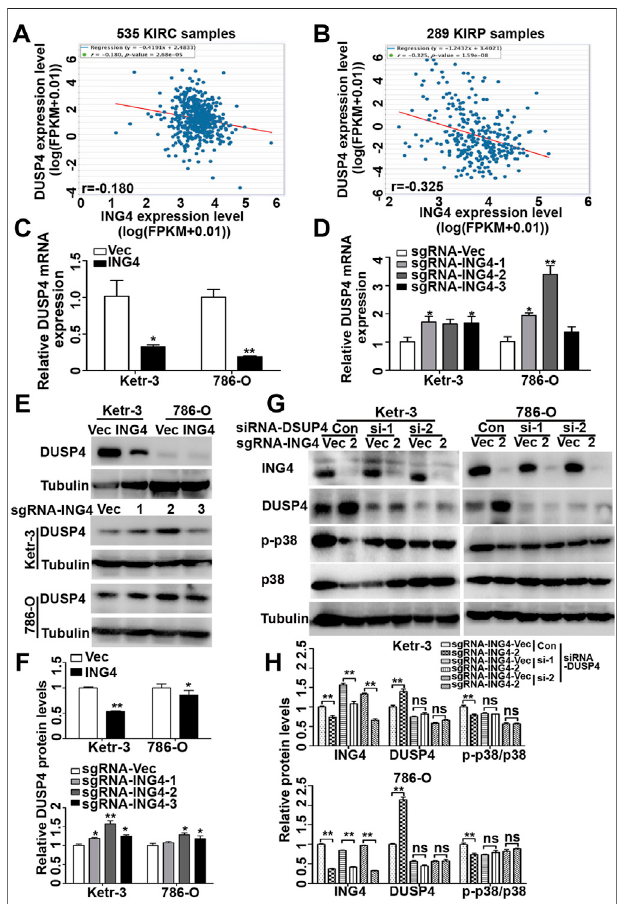
FIGURE 6 | ING4 inhibited the DUSP4 expression to regulate the p38 MAPK activity. (A – B) The mRNA correlation of ING4 with DUSP4 in TCGA- KIRC and TCGA-KIRP from the starBase v3.0 project. (C – D) Real-time PCR wasused totest the relative mRNAexpression levels ofDUSP4 in ING4- overexpressed (ING4) or knockdown (sgRNA-ING4) Ketr-3 and 786-O cells compared to the respective vector controls. (E – F) Western blot was used to test the protein expression of DUSP4 in ING4 overexpression (ING4) or knockdown (sgRNA-ING4) or their respective vectors Ketr-3 and 786-O cells and relative protein expression was normalized to that of respective α -tubulin. (G – H) Western blot was used to test the expression of ING4, DUSP4, p-p38, and p38 in ING4 knockdown (sgRNA-ING4-2) or vector control (sgRNA-Vec) Ketr-3 and 786-O cells after transfection with DUSP4 (si-DUSP4) or control siRNA (si-Con), and the relative protein expression of ING4 was normalized to that of the respective α -tubulin. Data are presented as mean ± standard deviation. * p < 0.05, ** p <